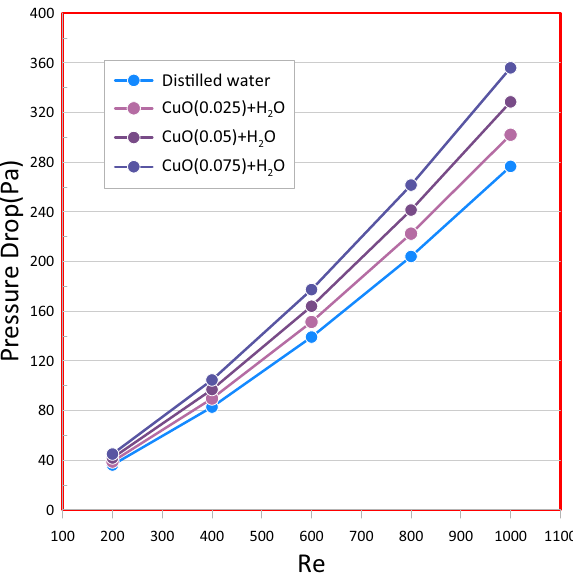
Figure 14. Show the effect of used nanofluid as acoolant on pressure drop.